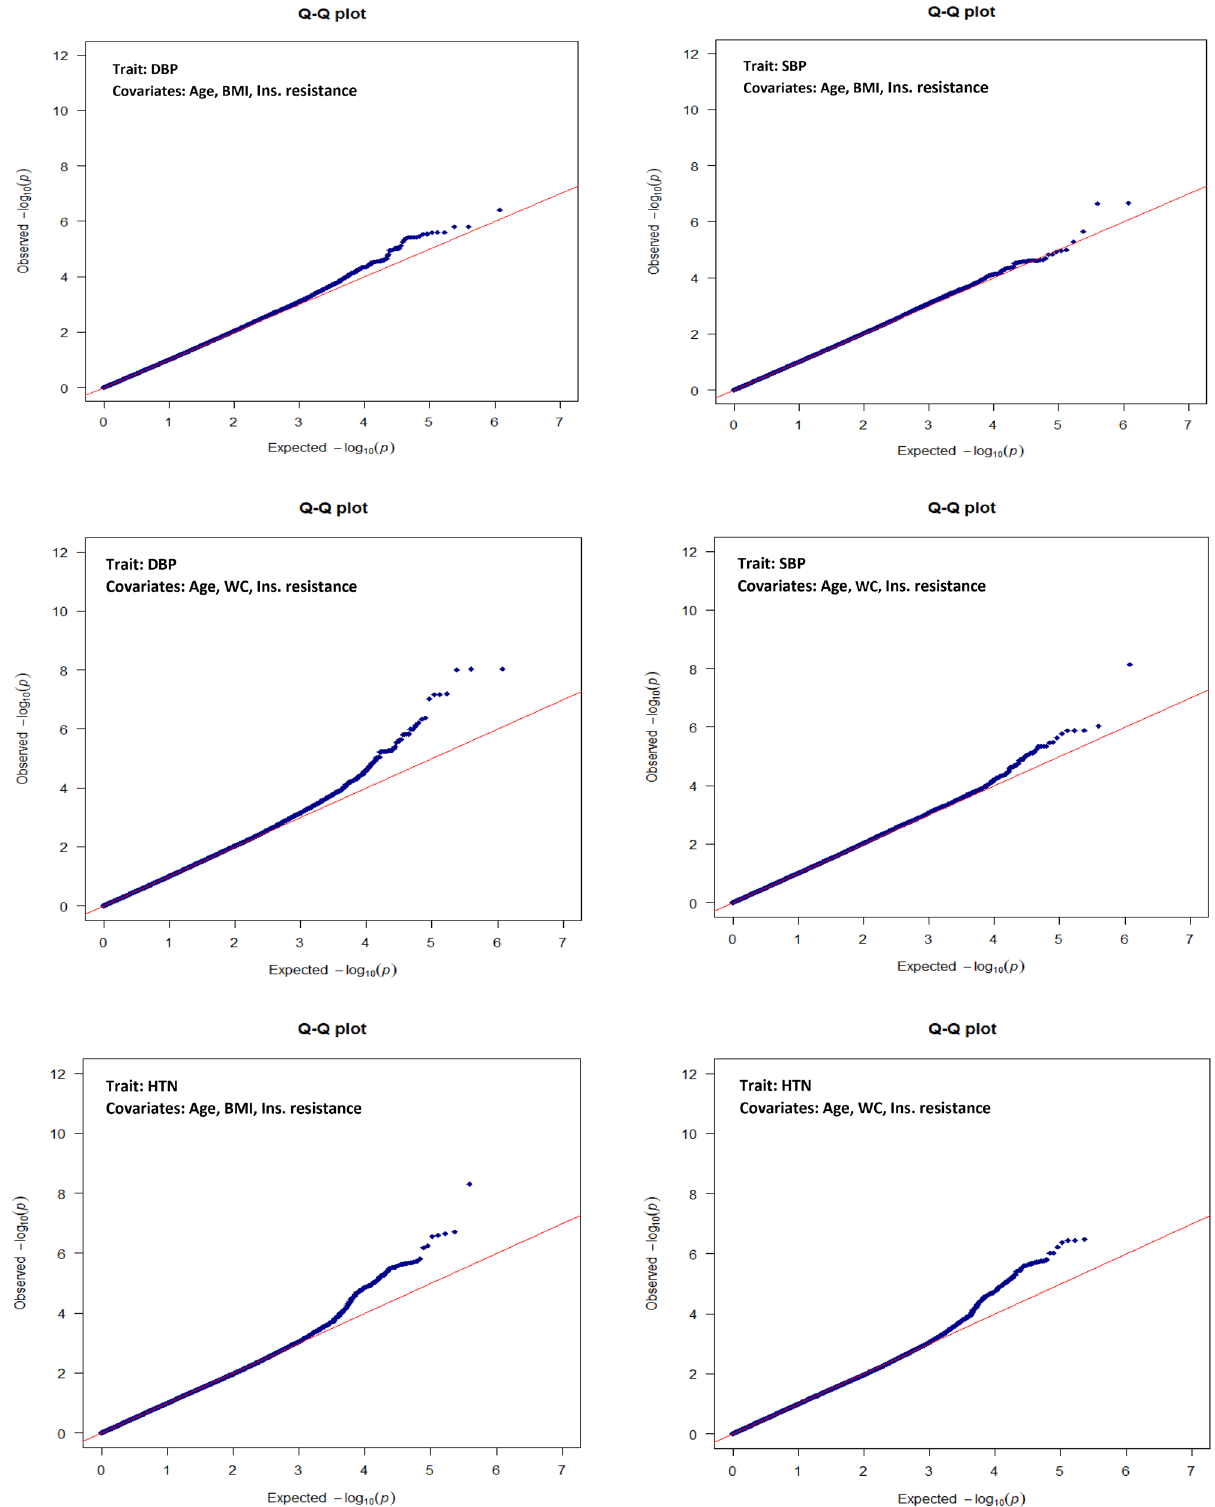
Figure 2. Q–Q plots of observed versus expected P values for BP quantitative and binary